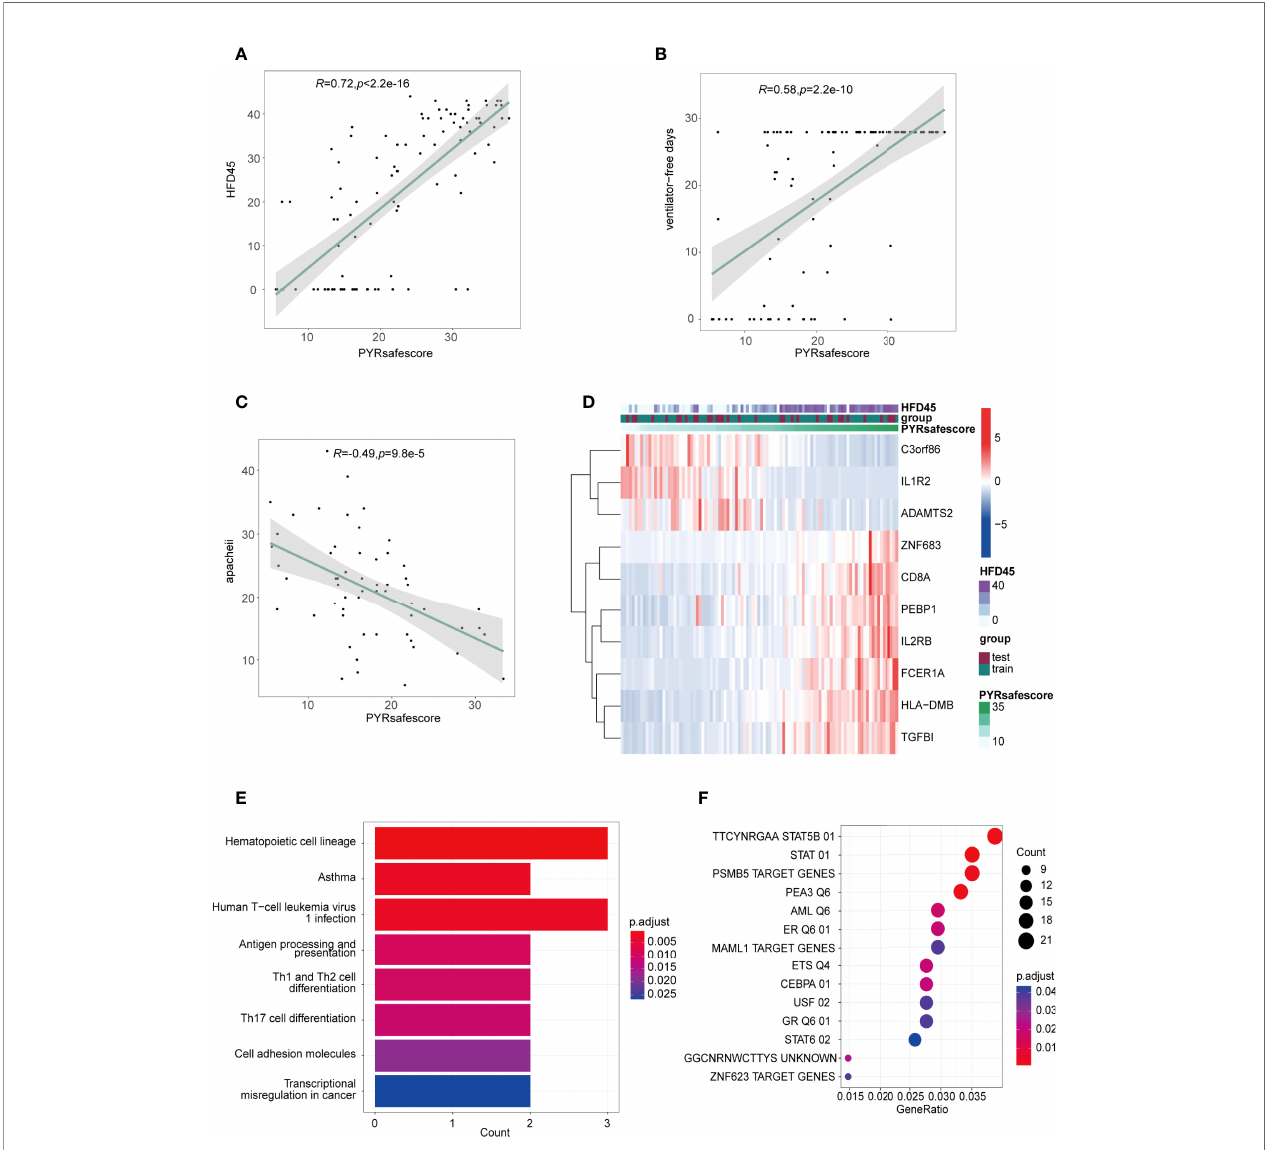
FIGURE 6 | (A, B, C) Pearson ’ s correlations between PYRsafescore and HFD45 (A) , ventilator-free days (B) , APACHE-II (C) , R value represents the Pearson ’ s correlation coef fi cient; grey area represents the 95% con fi dence interval for the linear fi t. (D) Heatmap of signature genes of PYRsafescore; expression of these genes was highly correlated with HFD45 and PYRsafescore. (E) Kyoto Encyclopedia of Genes and Genomes (KEGG) enrichment of signature genes of PYRsafescore. (F) Transcription factor enrichment of 570 DEGs between PYRclusters using “ clusterPro fi ler ” package based on MSigDB gene set: TFT (transcription factor targets) gene